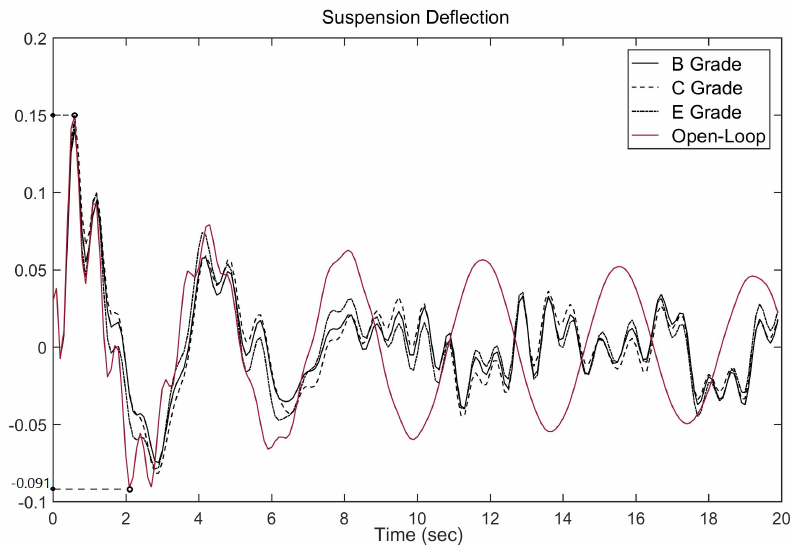
Figure 4. The comparison curves of SD under different road